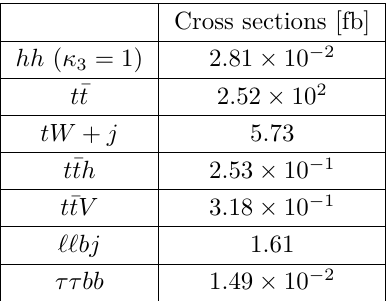
Table 1 . Signal and background cross sections after the baseline selection described in section 2, including appropriate k-factors as well as taking into account the improved b -tagging efficiency and fake